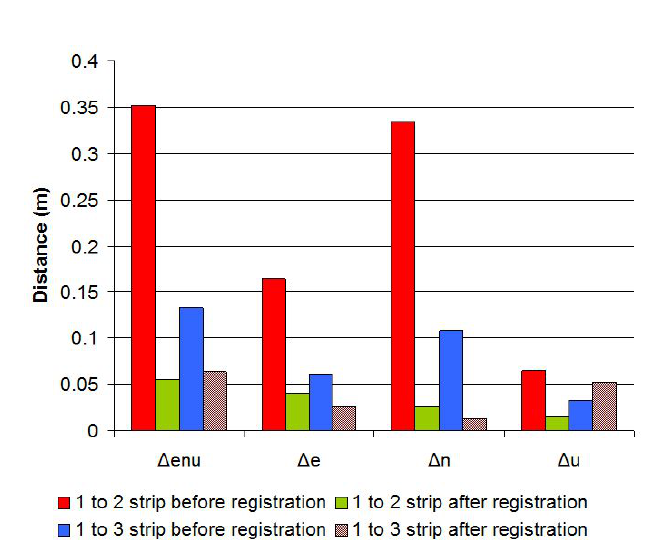
Figure 2: Point cloud differences from overlapping